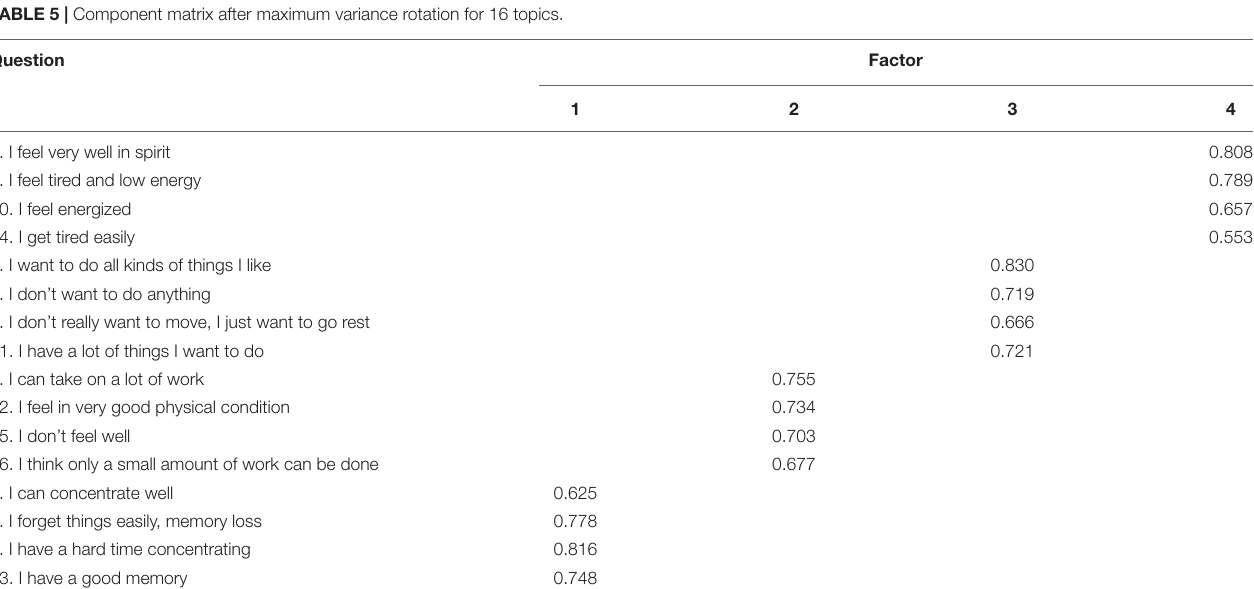
TABLE 5 | Component matrix after maximum variance rotation for 16 topics.